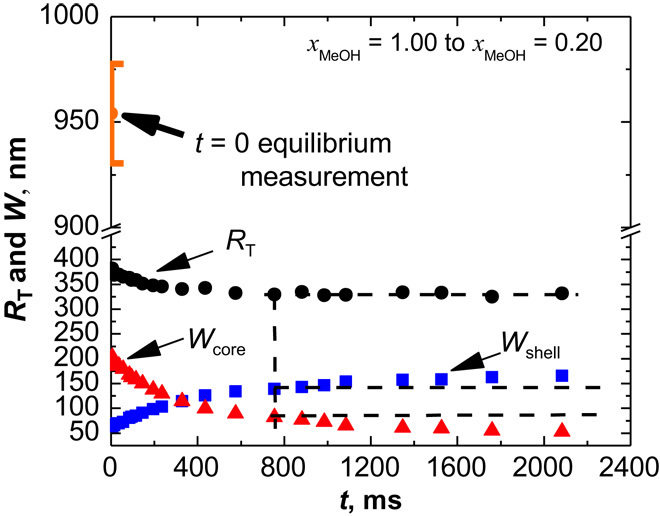
Microgel size and internal structure change from the form factor fit.The collapse transition of the PNIPAM microgel induced by the solvent composition change from pure MeOH to xMeOH = 0.20 is shown. The evolution of the microgel size RT, of the core region Wcore, and of the shell Wshell is represented in black, red, and blue, respectively.